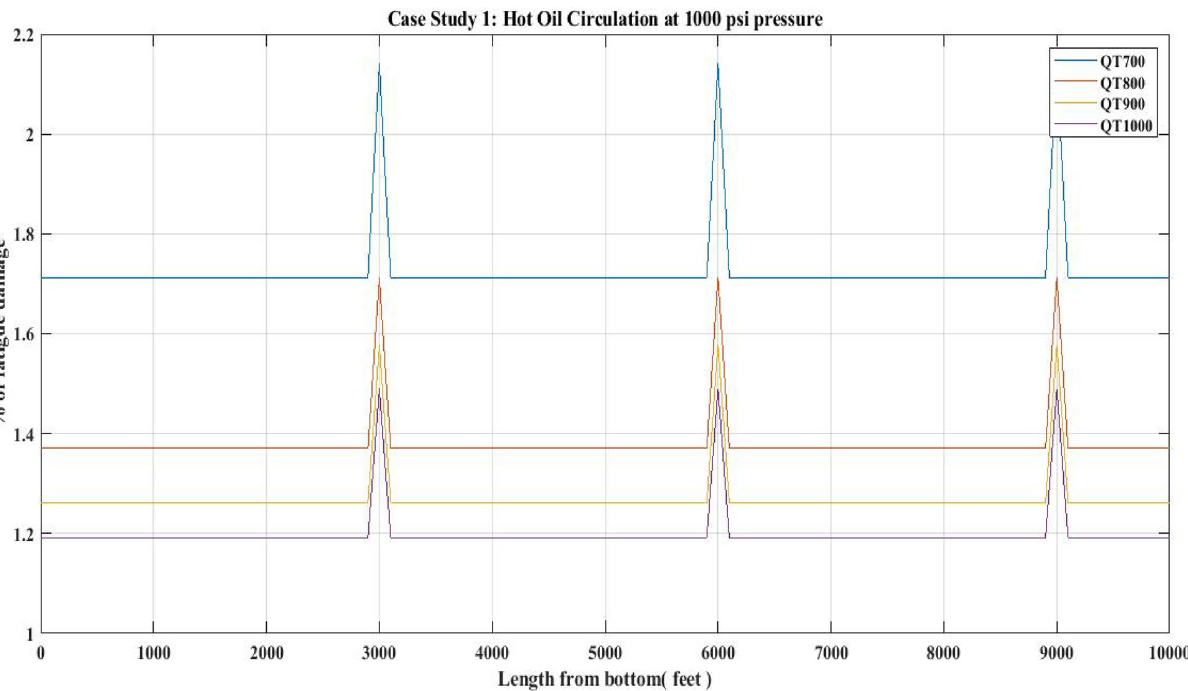
Figure 25. Percentage of fatigue damage with respect to hot oil circulation at 1000 psi